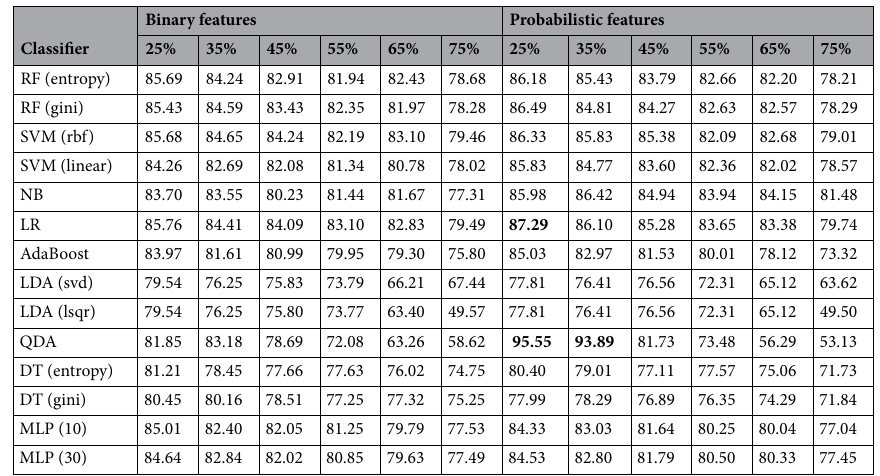
Table 2. Classification accuracy of NeurDNet in the two cases of employing binary and probabilistic features. The classification accuracy is measured across different choices of the second-stage classifier, including random forests (RF), support vector machines (SVM), Naive Bayes Classifier (NB), logistic regression (LR), AdaBoost classifier (AB), linear discriminant analysis (LDA), quadratic discriminant analysis (QDA), decision trees (DT), and multi layer perceptron (MLP).